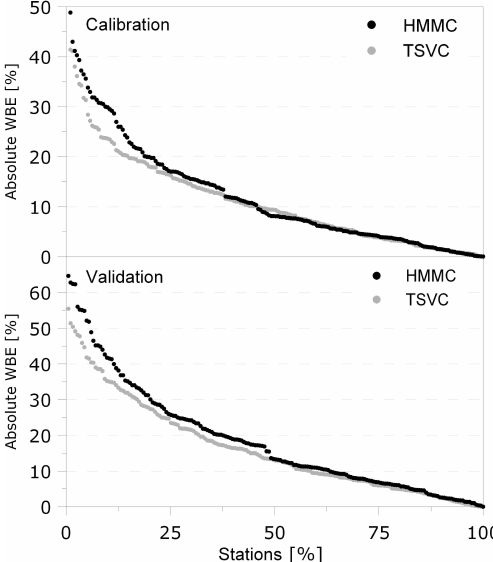
Fig. 10. Sorted model performance for absolute WBE for both mod- els during calibration and